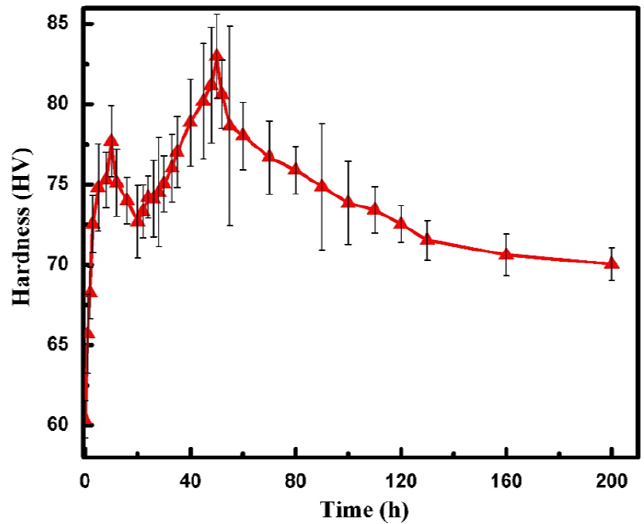
Figure 2. Age-hardening response of the TZA442 alloy.